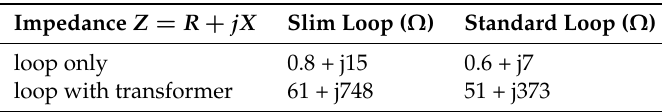
Table 2. Nominal IL impedance measured at 10